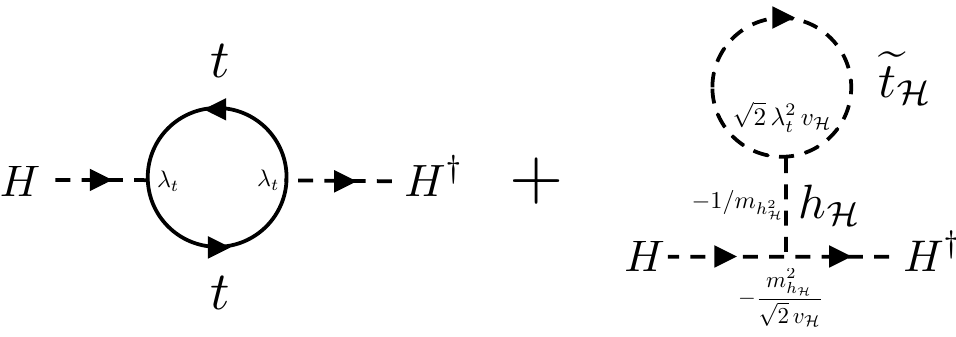
Figure 1 . The one-loop (cid:12)xed order corrections to the SM-like Higgs boson mass squared parameter, where t is a SM top quark, and eq. (1.1) and eq.